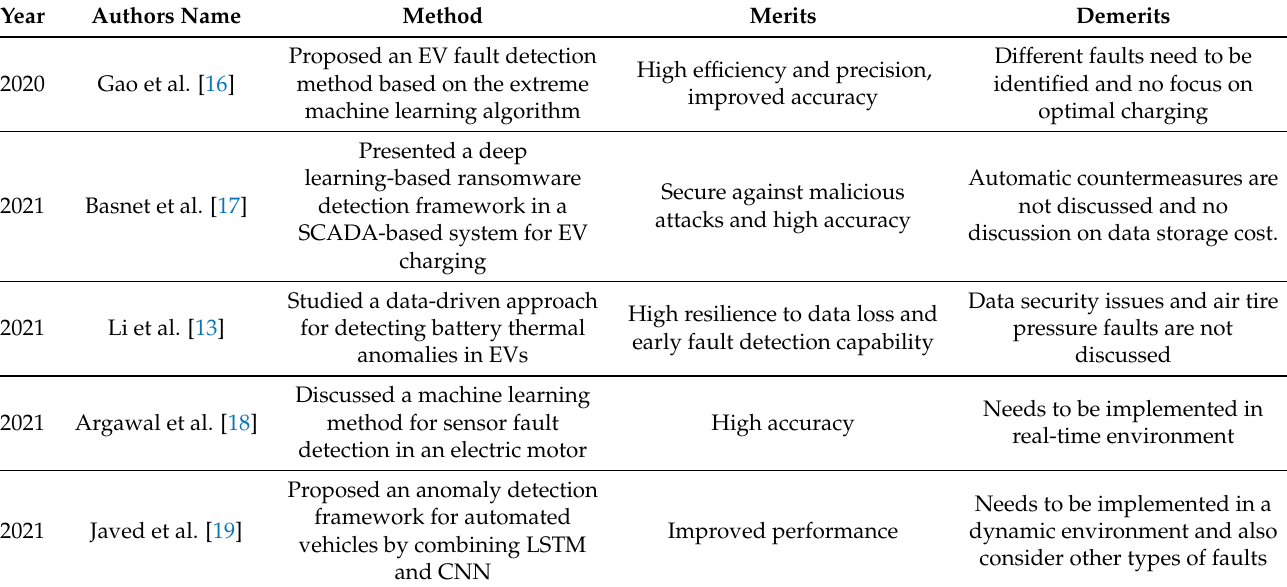
Table 2. Comparative analysis of various state-of-the-art EV fault detection schemes with the pro- posed